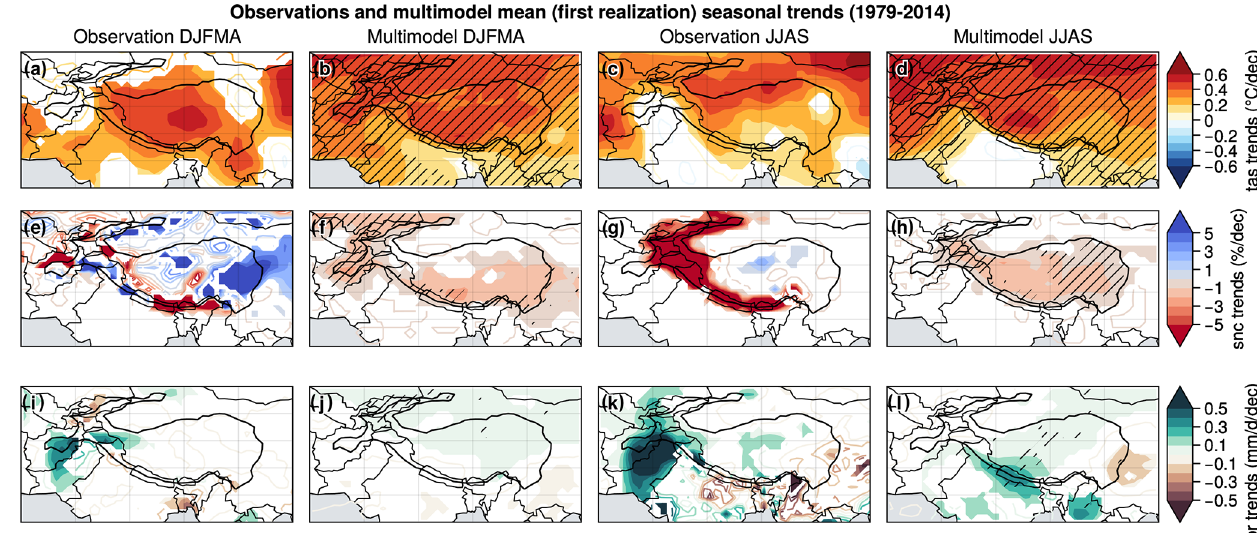
Figure 7. DJFMA (left) and JJAS (right) trends computed over 1979–2014 for temperature (a–d) , snow cover (e–h) and precipitation (i– l) . CRU temperature, NOAA CDR snow cover and APHRODITE precipitation observation trends (DJFMA: a, e, i and JJAS: c, g, k ) are compared to the multimodel mean computed with the first realization for each model (DJFMA: b, f, j and JJAS: d, h, l ). Contours are used for non-significant trends, shading for significant trends ( p value > 0.05) and hatching for points where > 80% of the models agree on the sign of the